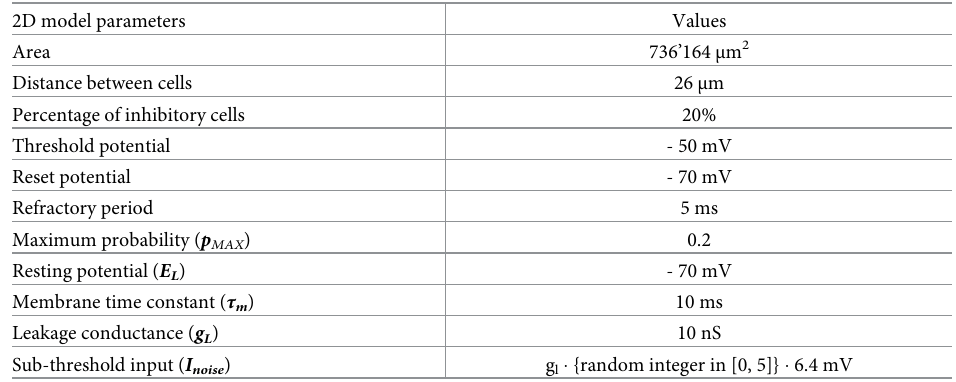
Table 1. List of the parameters of the 2D model.